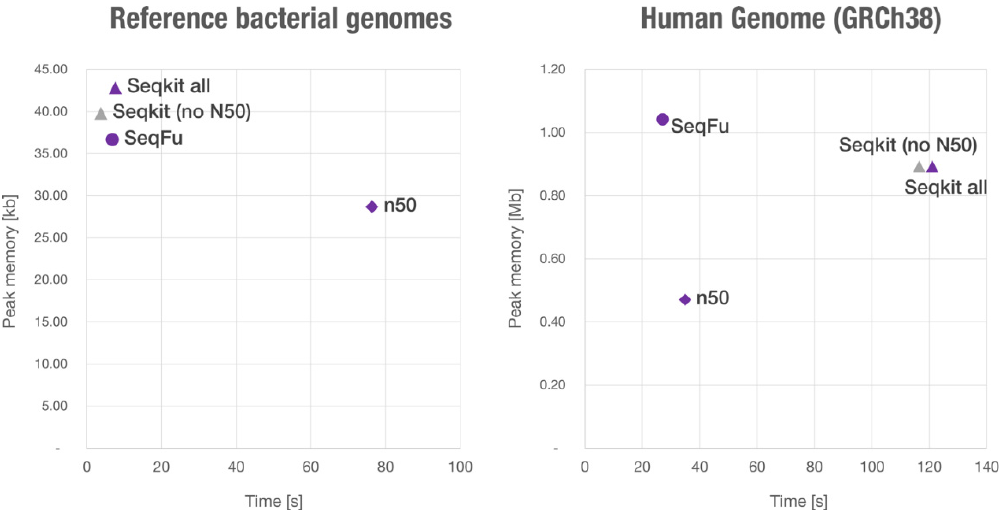
Figure 4. Memory consumption and execution times of Seqkit, SeqFu and n50 using two datasets (reference bacterial genomes from the gastrointestinal tract, left, and the human genome, right). SeqKit has been used with default parameters (no N50) which skips the calculation of extended statistics, and with the ‘—all’ parameter (labelled as Seqkit all ). SeqFu is the faster tool in both datasets, with a remarkable difference when parsing a file with few large sequences (human genome).